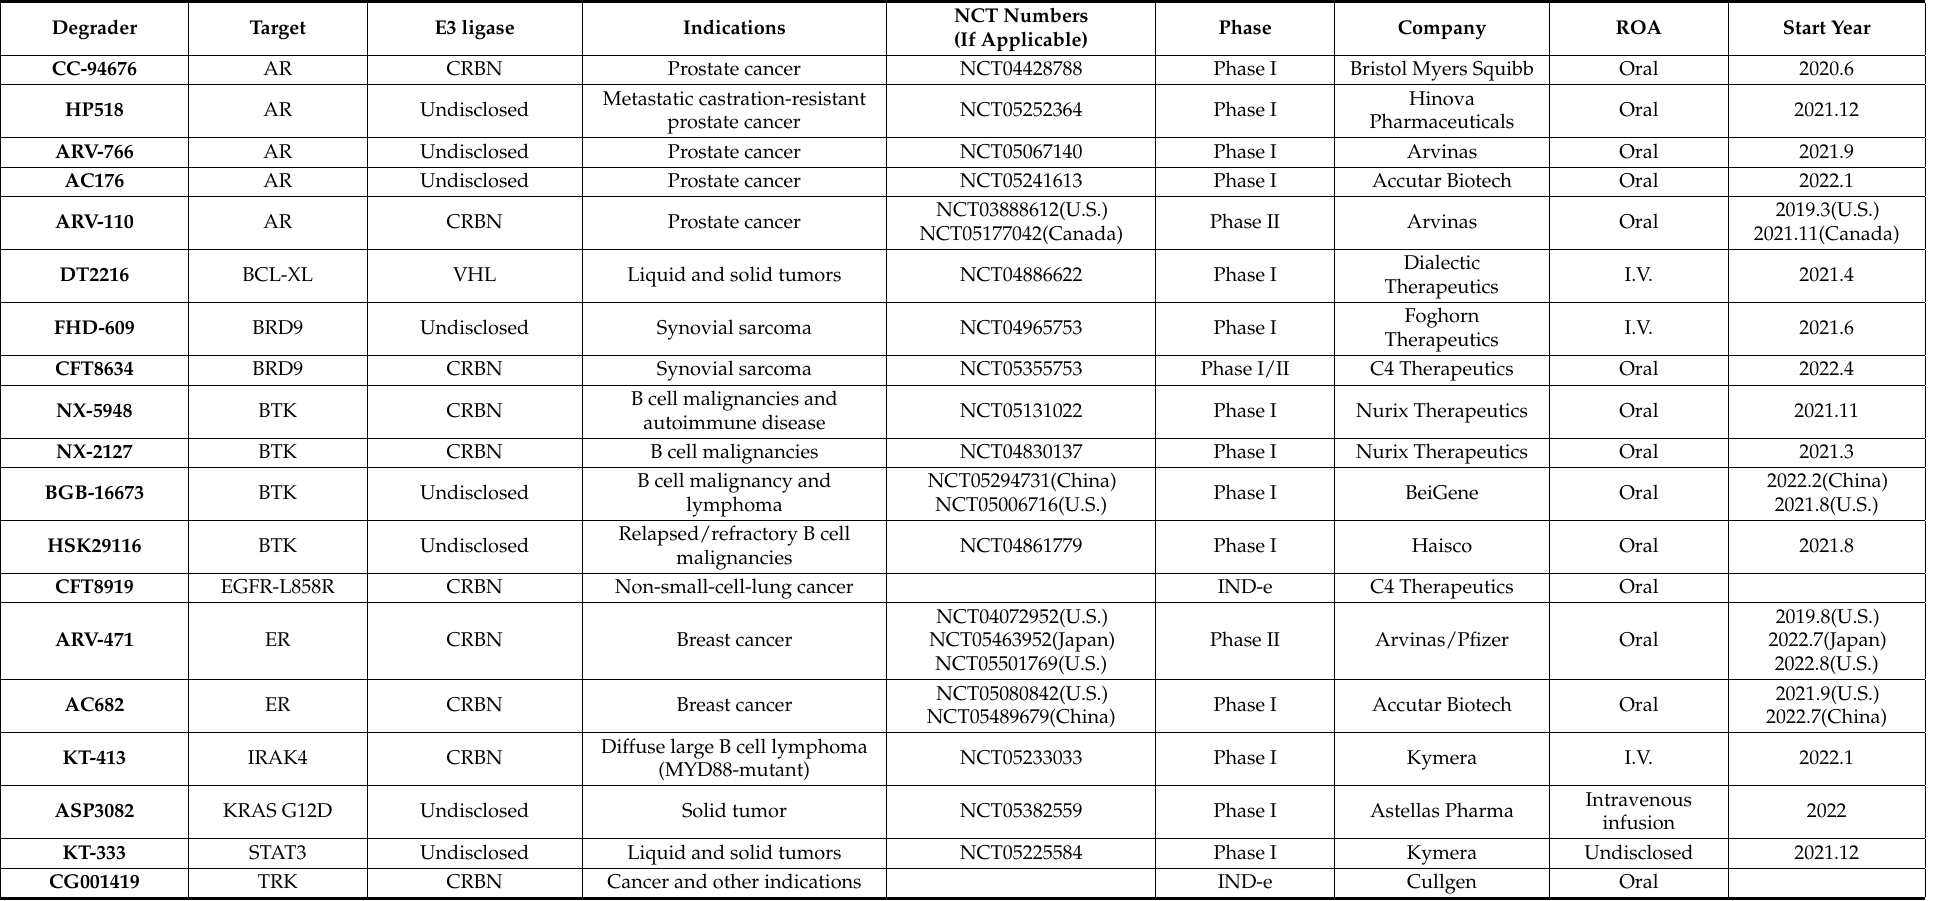
Table 1. PROTACs in clinical